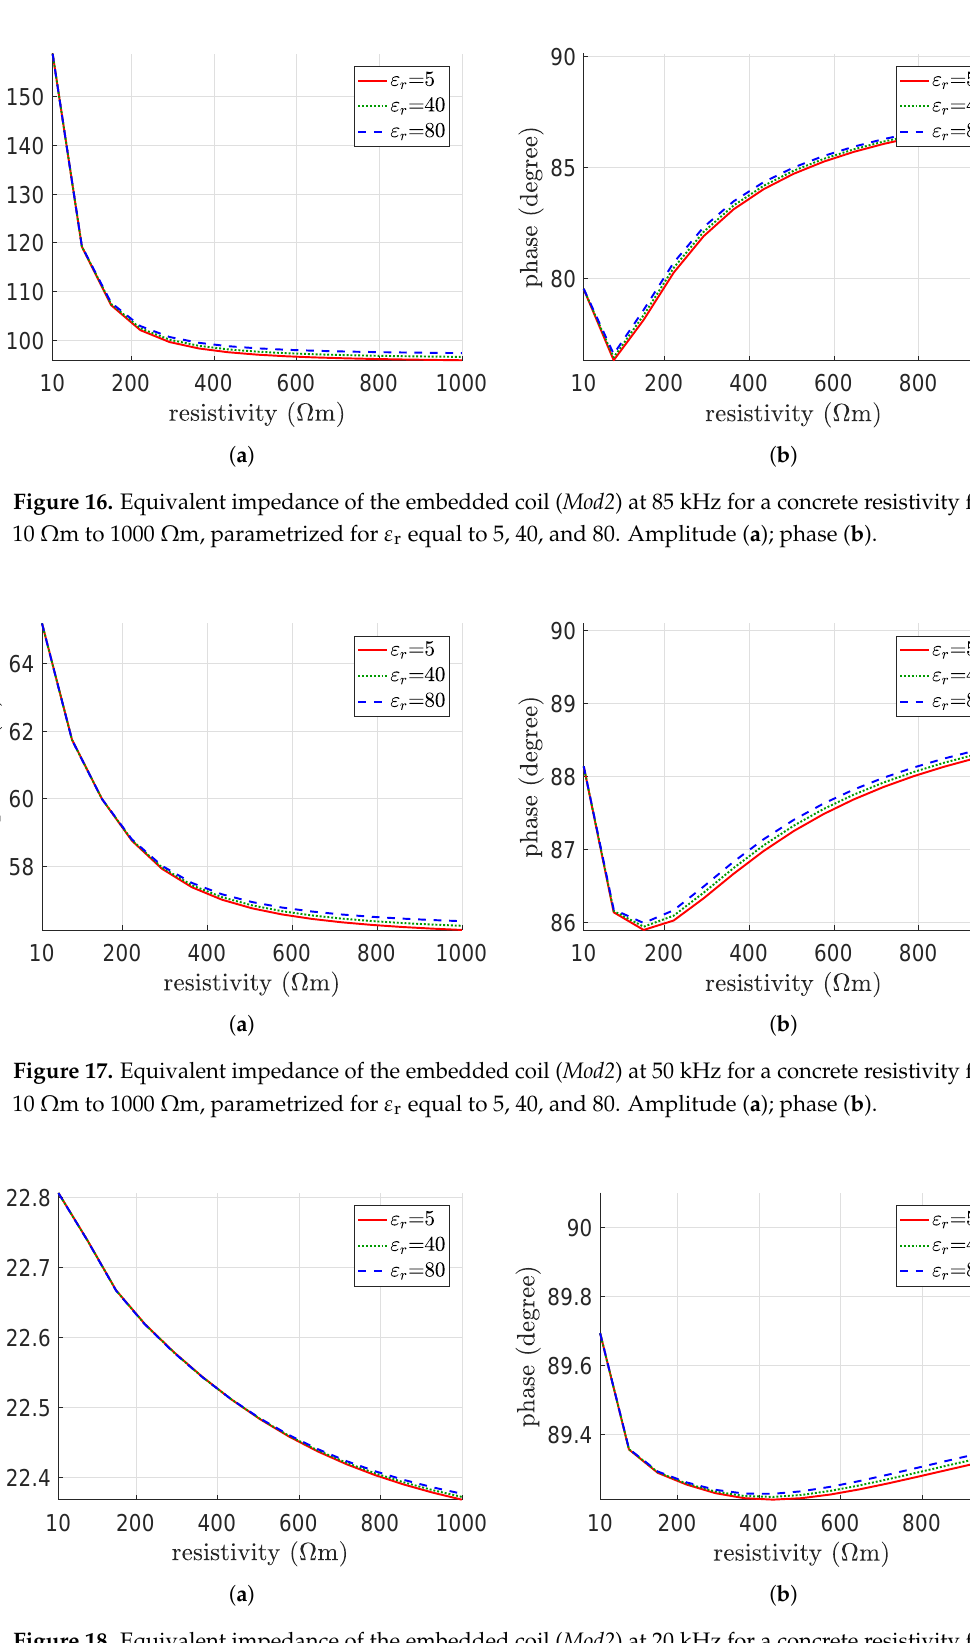
Figure 18. Equivalent impedance of the embedded coil ( Mod2 ) at 20 kHz for a concrete resistivity from 10 Ω m to 1000 Ω m, parametrized for ε r equal to 5, 40, and 80. Amplitude ( a ); phase ( b